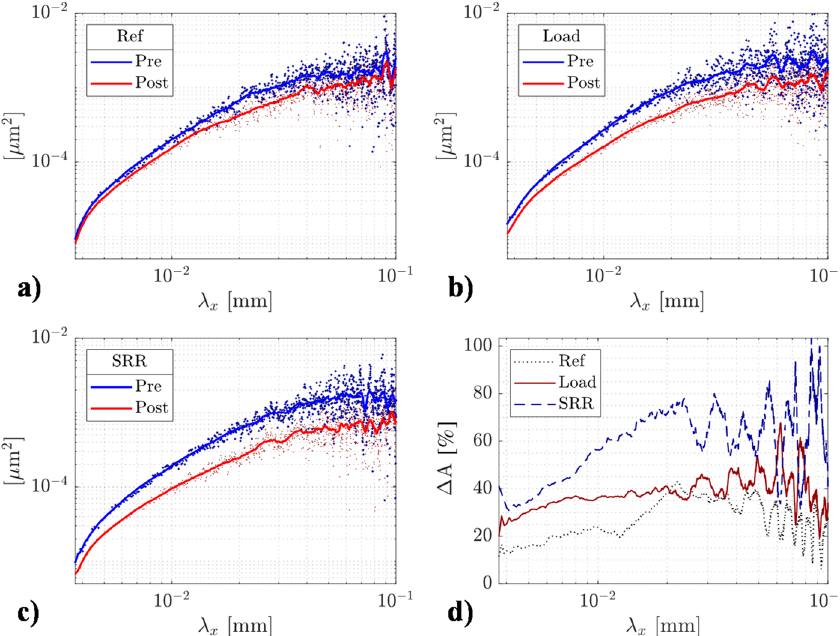
Figure 7. PSD (amplitude versus spatial wavelength) curves showing the spectral distribution of the 65% highest peaks of the pre-test and re-located surfaces. The FFT analysis was conducted in the direction of entrainment (and sliding) to detect any residues from the film formation process: ( a ) Ref, ( b ) Load, ( c ) SRR, and ( d ) all compared by percent